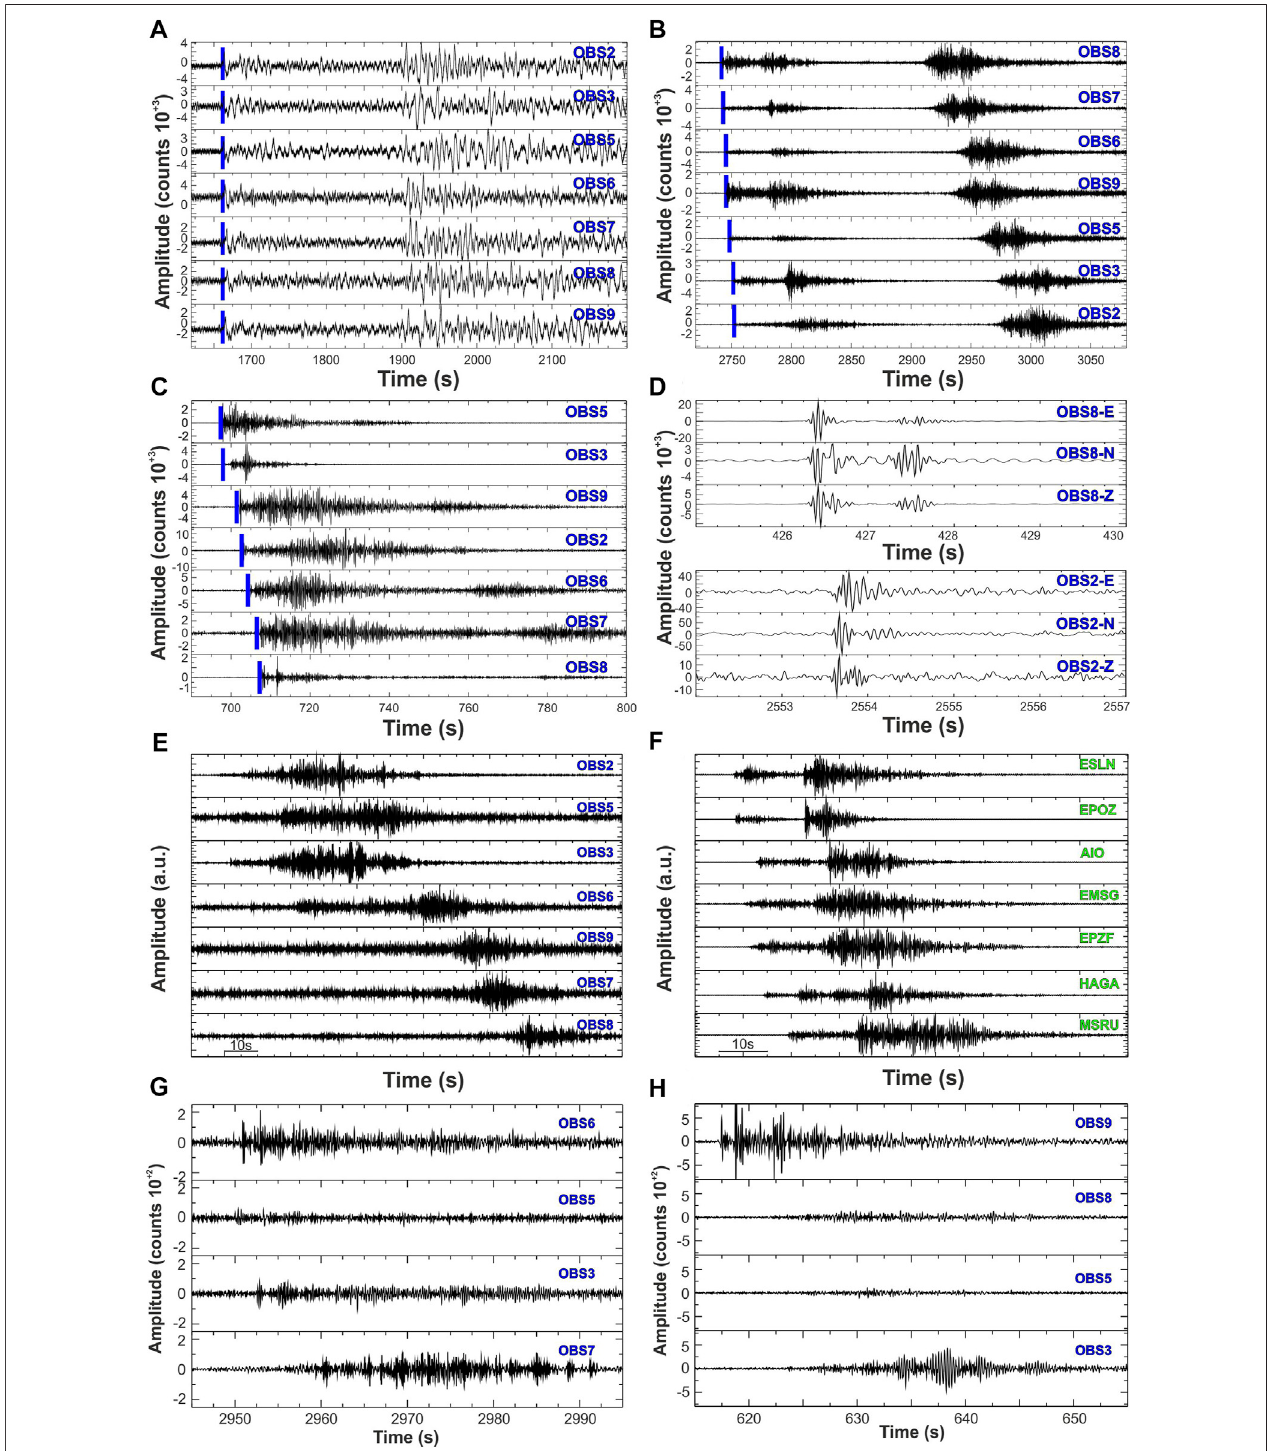
FIGURE 3 | Example of seismic waveforms recorded by the OBS network (A) teleseismic event (vertical component, un fi ltered; 2018, January 14 h 09:18 UTC M (cid:2) 7.1 38 km SSW Acari, Perù) (B) regional earthquake from Greece (vertical component, 2 – 12 Hz fi ltered; 2018, February 21 h 23:44 UTC, M L (cid:2) 4.8) (C) local earthquake(verticalcomponent,2 – 12 Hz fi ltered;2017,October23 h19:11UTC,M L (cid:2) 3.0);theblueverticalbarsonearthquakesignalsindicatetheP-wavearrivals (D) Examples of short duration events (three-components, 2 – 12 Hz fi ltered) recorded by OBS8 (up) and OBS2 (bottom) , respectively (E – F) Waveforms (vertical components, 2 – 12 Hz fi ltered) of an earthquake occurring in the Etna area (2017, June 23 h 20:32 UTC, M L (cid:2) 2.2) located by land network (an example of waveforms